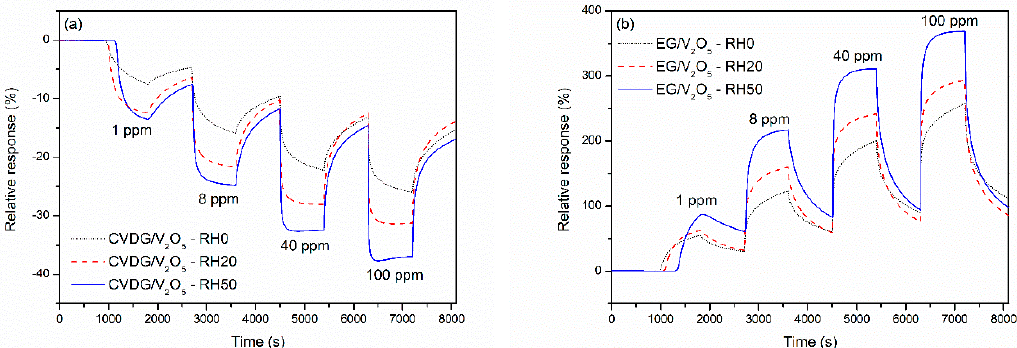
Figure 5. Influence of humidity content on gas responses of sensors based on V 2 O 5 functionalised ( a ) CVD graphene on Si/SiO 2 , and ( b ) EG on SiC to varying NH 3 concentrations at the room temperature. Permanent UV light was on during the measurements; the time intervals of gas exposure and recovery were 900 s.